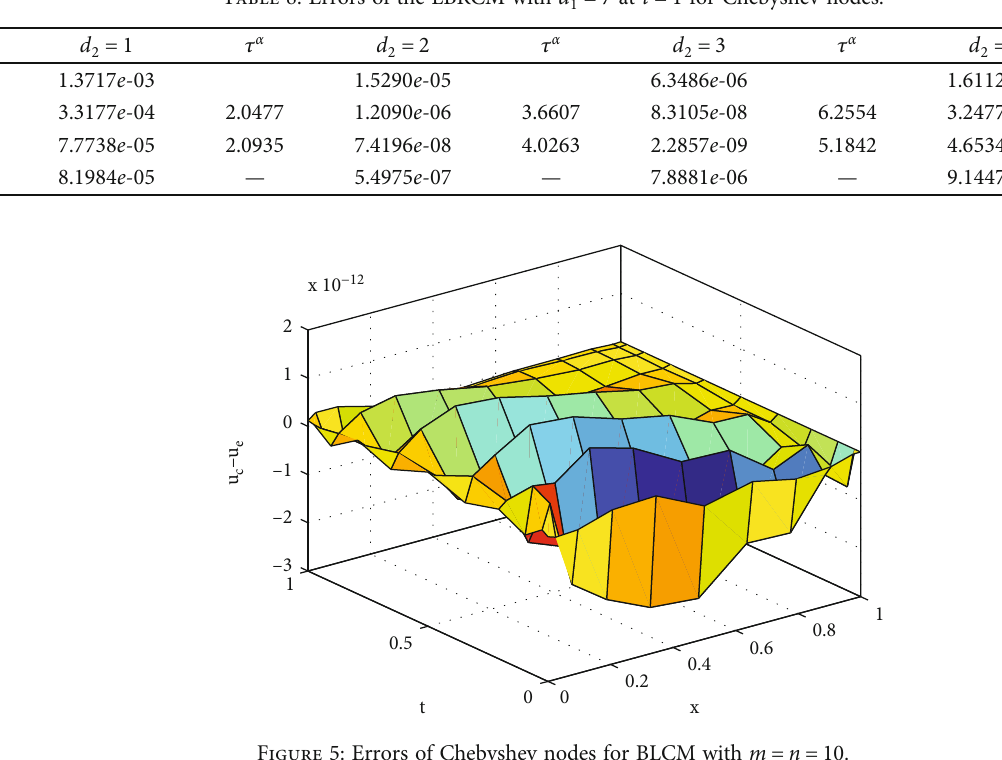
Table 8: Errors of the LBRCM with d